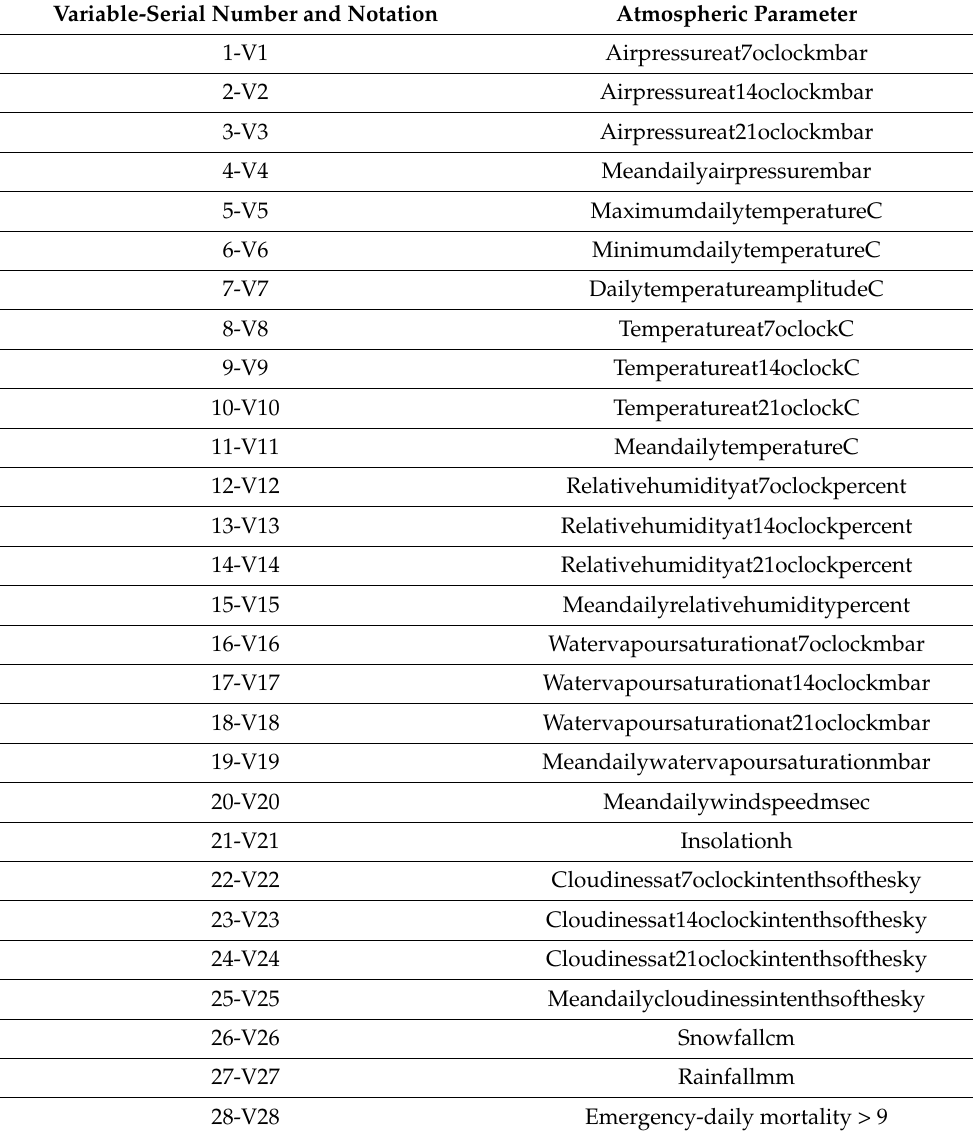
Table 2. Twenty-seven atmospheric parameters used in the case